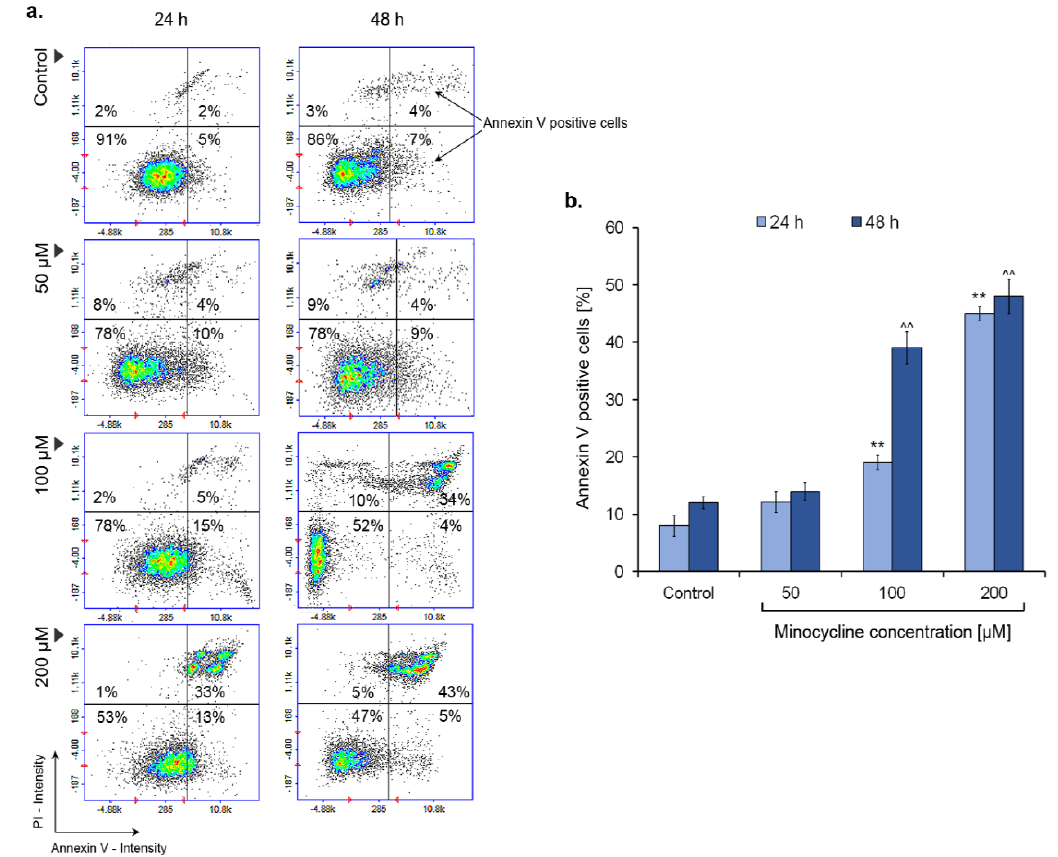
Figure 6. Minocycline induces apoptosis in human melanoma cells—the results of annexin V assay after 24 h and 48 h incubation. Representative scatter plots display a tested cells population divided by a gate into the subpopulations of healthy and apoptotic—annexin V-positive cells ( a ). Mean values of the percentage of annexin V-positive cells are presented in the bar graph ( b ). ** p < 0.005 vs. control 24 h; ^^ p < 0.005 vs. control 48 h.